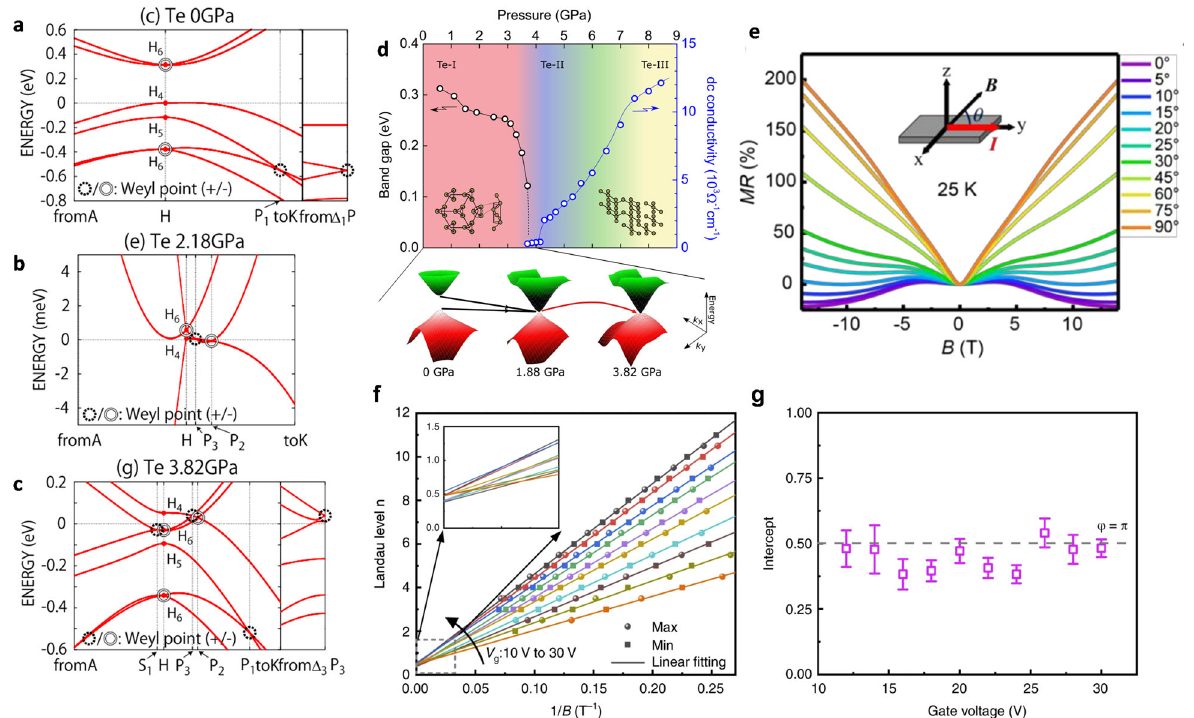
Fig. 5 Topological properties of Te. a – c Topological transitions of Te electronic structures under pressures of 0, 2.18, and 3.82 GPa, respectively. Without pressure, Weyl nodes on the H-K line from accidental crossing and Kramers-Weyl nodes at the H point are present, along with a trivial bandgap near the Fermi level. It undergoes a transition from trivial insulator to Weyl semimetal with increased pressure. ( a – c ) reproduced from ref. 108 . d Experimental evidence of topological phase transition under pressure from infrared response and X-ray diffraction. Reproduced from ref. 113 e Chiral anomaly induced negative magnetoresistance in p-type bulk Te as evidence of Weyl nodes in the valence band. Reproduced from ref. 117 . f , g Landau fan diagram constructed from SdH oscillation sequences in n-type 2D Te fi lm with non-trivial π Berry phase as a manifestation of Weyl nodes near conduction band edge. ( f , g ) reproduced from ref. 76